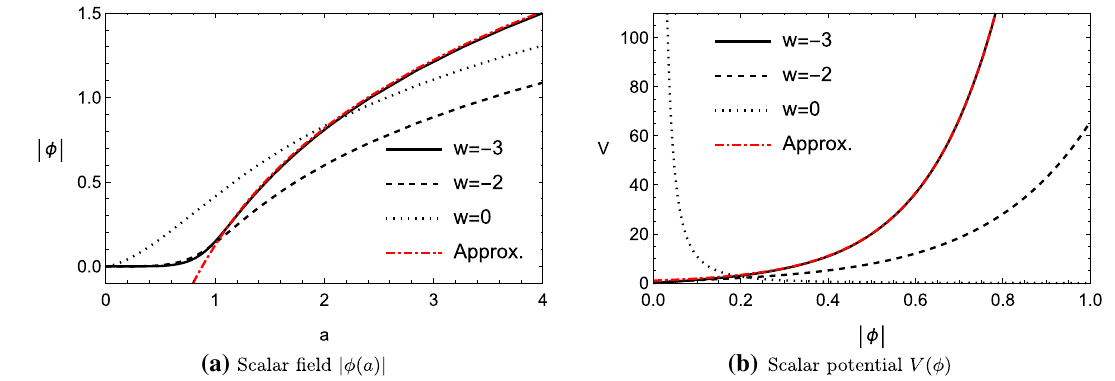
Fig. 4 Scalar field | φ | ( a ) and its potential V (φ) for different w and p + = p − = V 0 = 1; the red curves correspond to the approximations